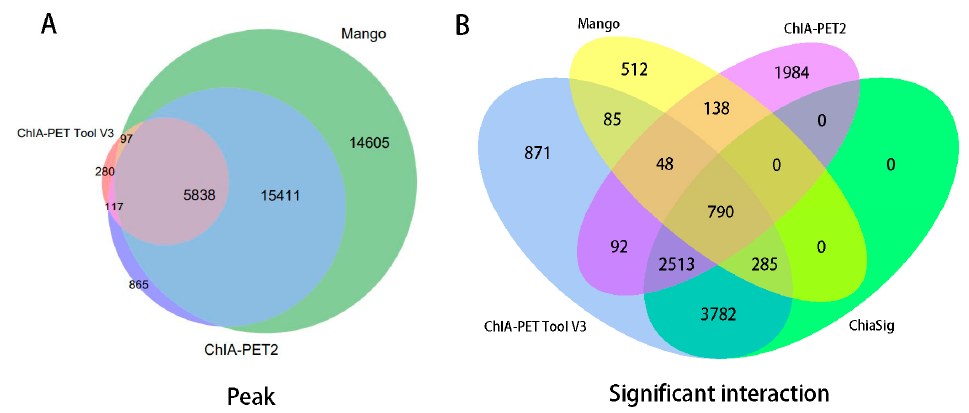
Figure 10. Overlap of ( A ) peaks and ( B ) interactions detected by different tools from human K562 cells. Significant interactions are required for at least three supportive PETs and FDR less than 0.05.